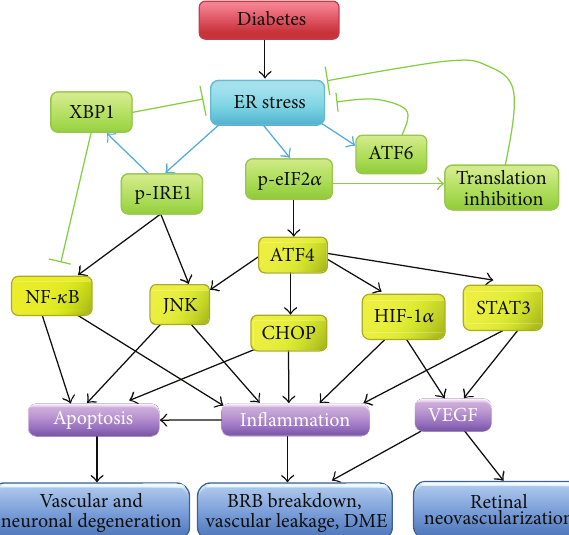
Figure 3: Pathogenic role of persistent ER stress in diabetic retinopathy. Chronic hyperglycemia, altered energy and metabolic hemostasis, and other detrimental factors such as oxidative stress result in ER stress in retinal cells during diabetes. While tempo- rary and mild ER stress can be overcome by the adaptive UPR, persistent ER stress activate proinflammatory and proapoptotic signaling pathways leading to apoptosis, inflammation, increased VEGF production, and ultimately BRB breakdown, retinal NV and neuronal